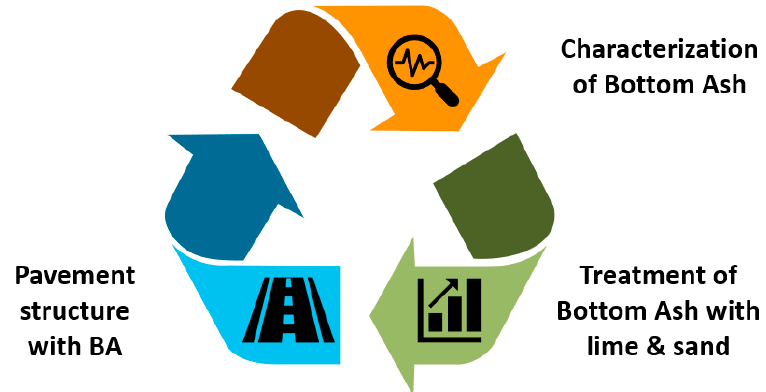
Figure 1. Methodology of this study comprising of three phases: characterization, treatment with lime and sand, and implementation in the theoretical design of a pavement structure.